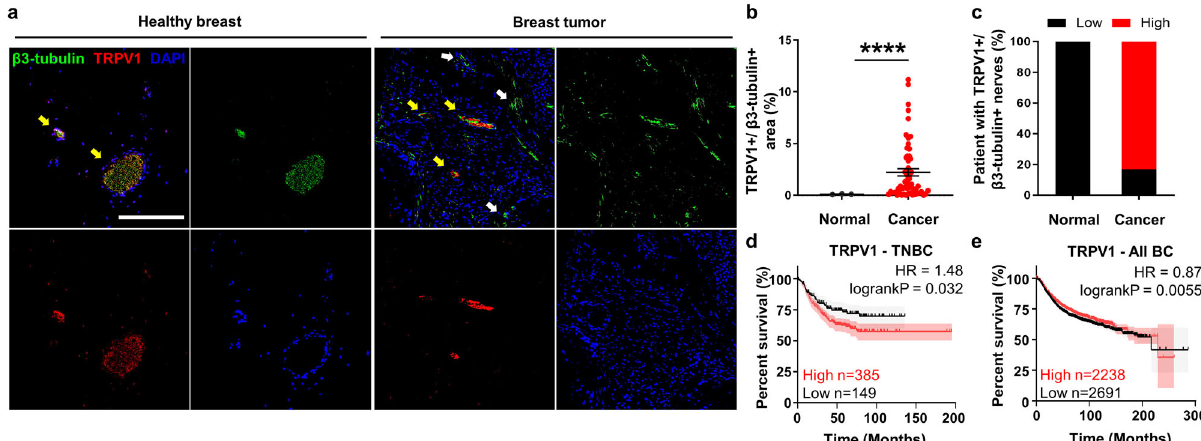
Fig. 1 Sensory nerves are abundant in TNBC tumor tissue. a Immunostaining of human breast tissue from a tissue microarray stained for β 3- tubulin, TRPV1, and nuclei. White arrows show β 3-tubulin + nerve fi bers, yellow arrows show sensory nerve fi bers positive for both TRPV1 and β 3-tubulin (TRPV1 + / β 3-tubulin + ), scale bar denoting 200 μ m. b Quanti fi cation of TRPV1 + and β 3-tubulin + sensory nerve area relative to tumor area (**** p < 0.0001, signi fi cance was determined by unpaired t test with Welch ’ s correction). c Percent patients with high levels of TRPV1 + / β 3-tubulin + sensory nerve presence. d Kaplan – Meier curve of TNBC patients comparing outcomes for patients with low or high TRPV1 mRNA expression. e Kaplan – Meier curve of all breast cancer patients comparing outcomes for patients with low or high TRPV1 mRNA